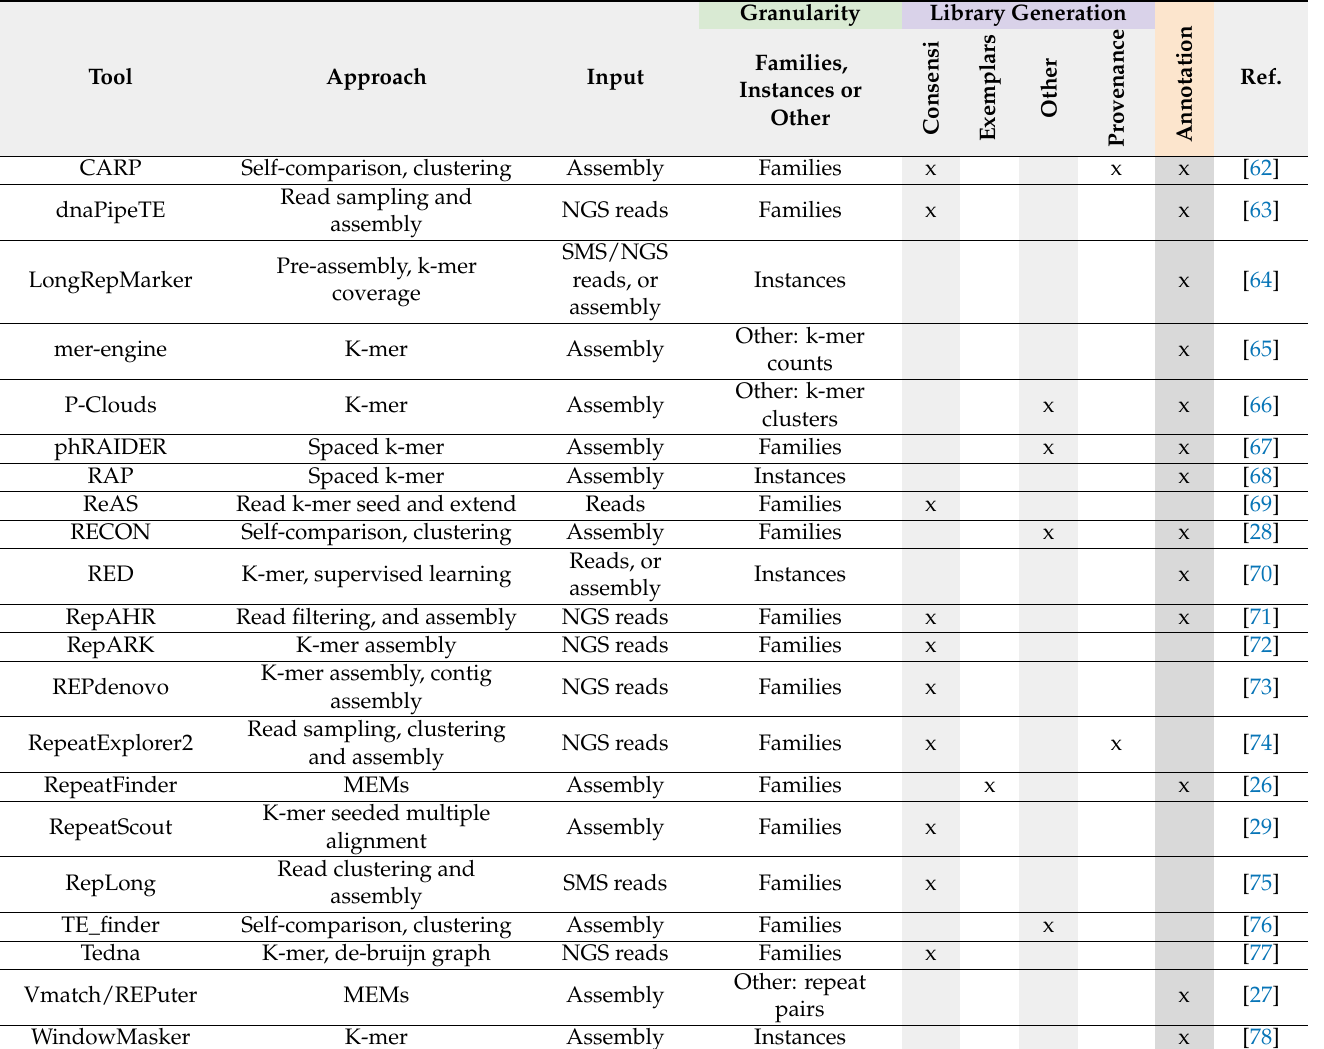
Table 1. De novo